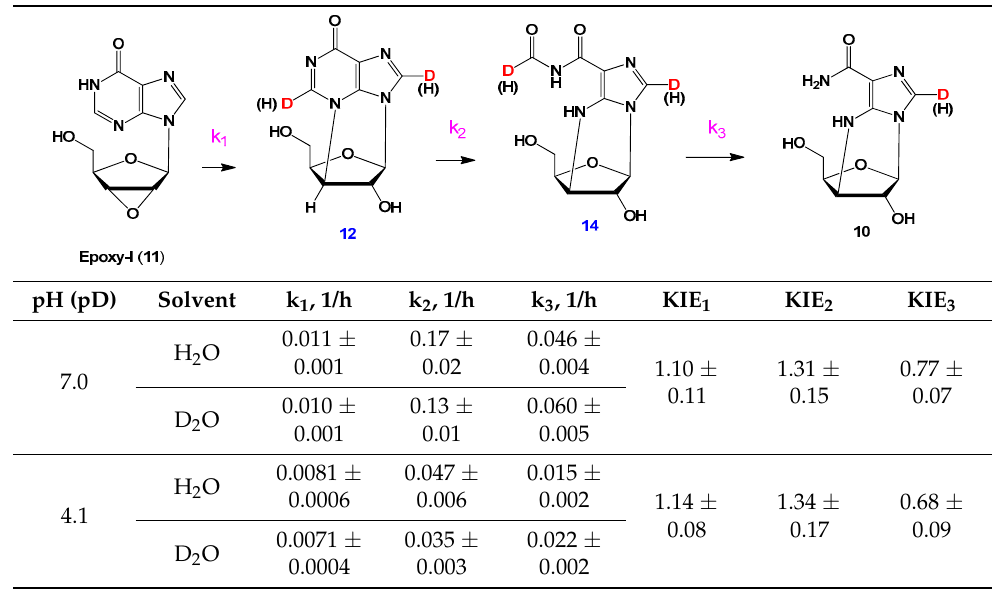
Table 1. Reaction rate constants and solvent kinetic isotope effects for synthesis of 12 , 14, and 10 .